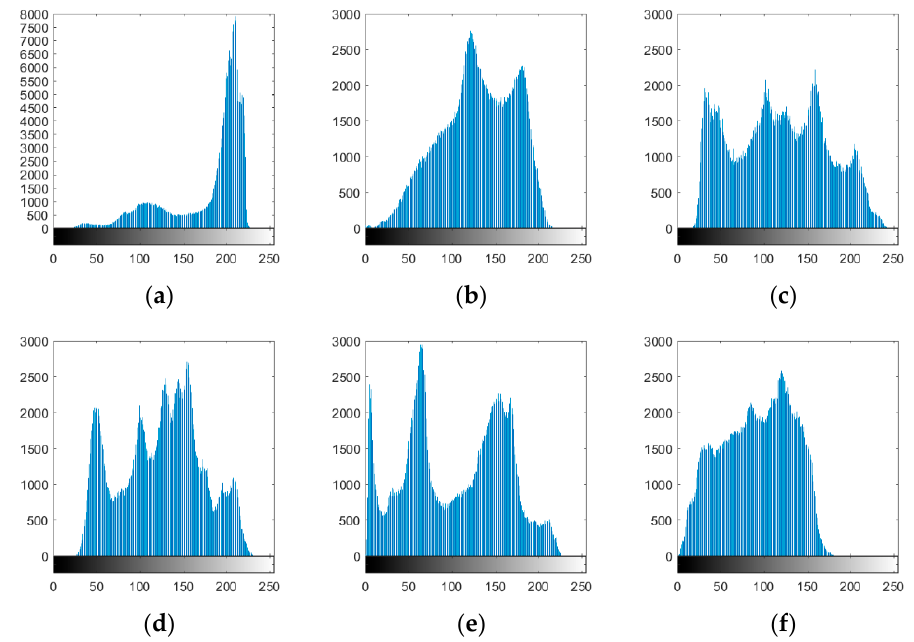
Figure 6. Histograms of the original image. ( a ) Airplane; ( b ) Baboon; ( c ) Barbara; ( d ) Lena; ( e ) Peppers; ( f ) Zelda.